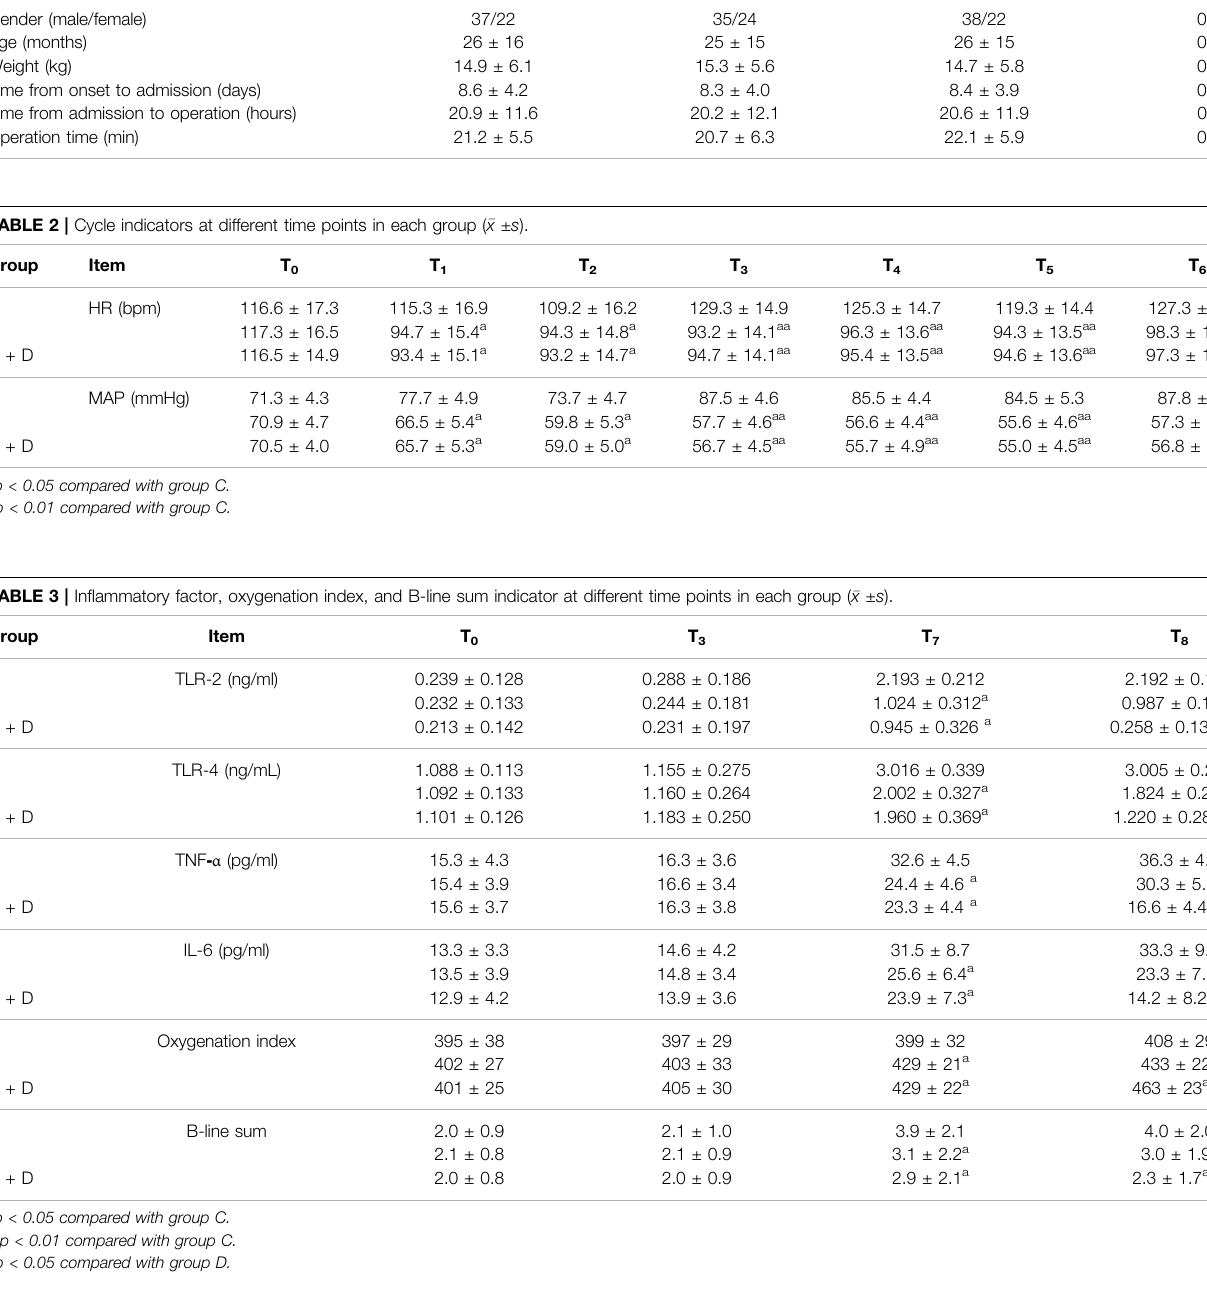
TABLE 4 | Immediate extubation agitation score and Ramsay score at different time points in each group ( (cid:1) x ±s ). Group T 3 (agitation score at tube